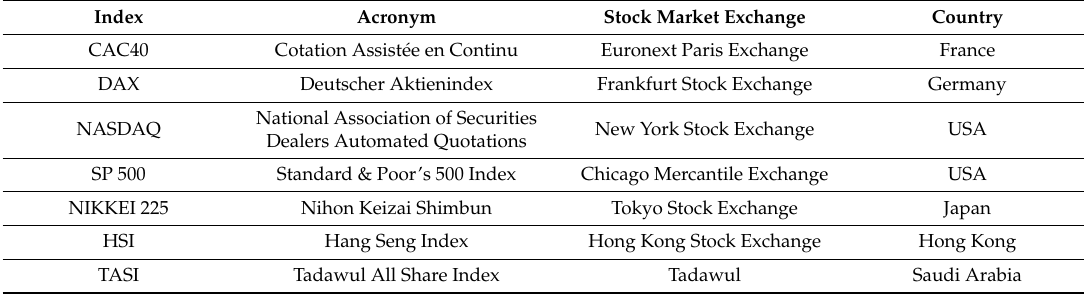
Table 1. The description of international stock market indices